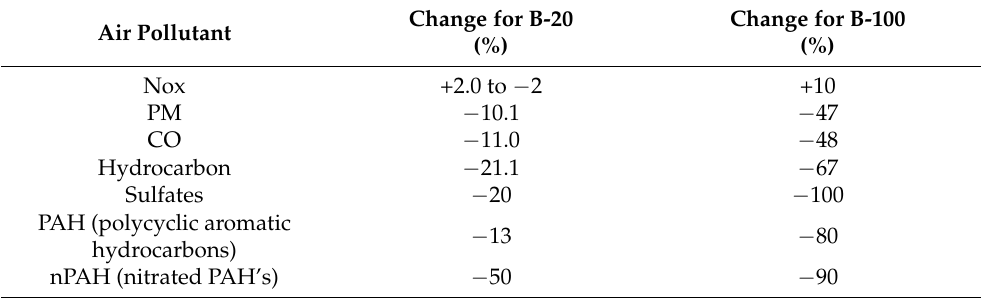
Figure 13. Political, economic, social, and tech (PEST) analysis. Table 11. The average effect of 20% and 100% biodiesel on heavy-duty emissions compared to average typical diesel [37,171,172].